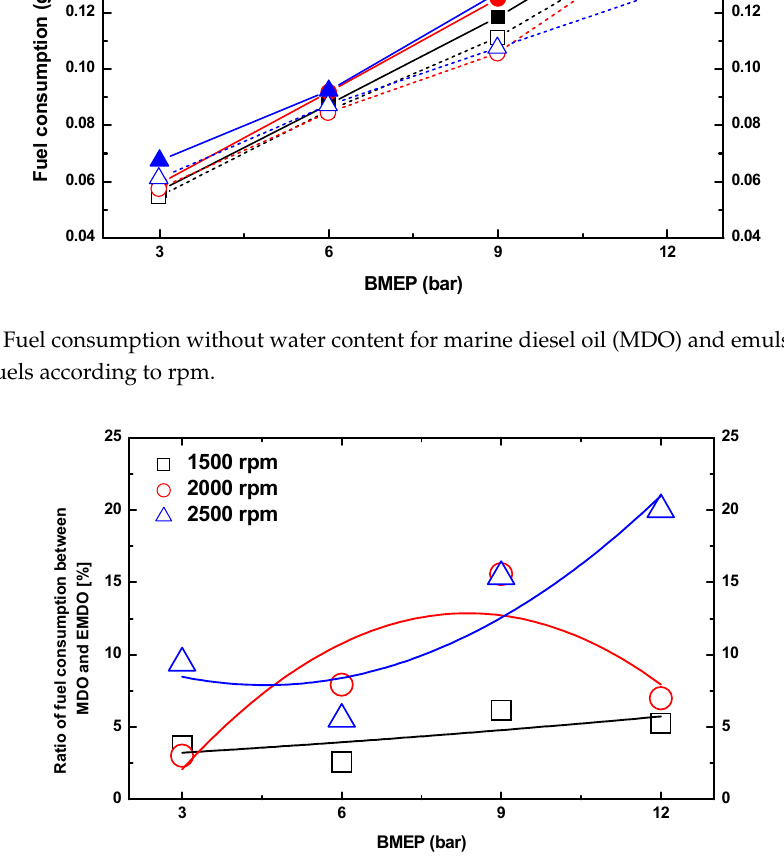
Figure 11. Ratio of fuel consumption without water content for marine diesel oil (MDO) and emulsified MDO (EMDO) fuels according to rpm.